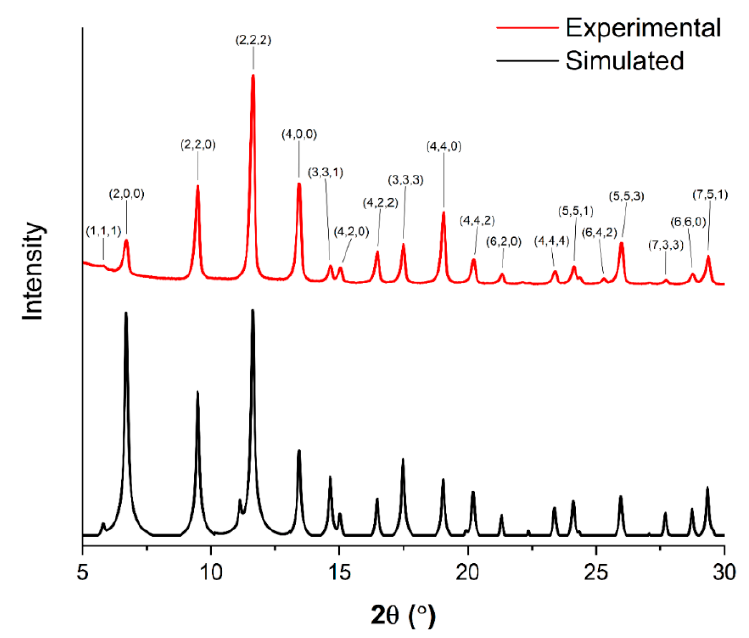
Figure 6. Powder X-ray diffraction (PXRD) pattern of flow processed electrochemically synthesised HKUST-1 using 0.05 M H 3 BTC, and a simulated HKUST-1 pattern.